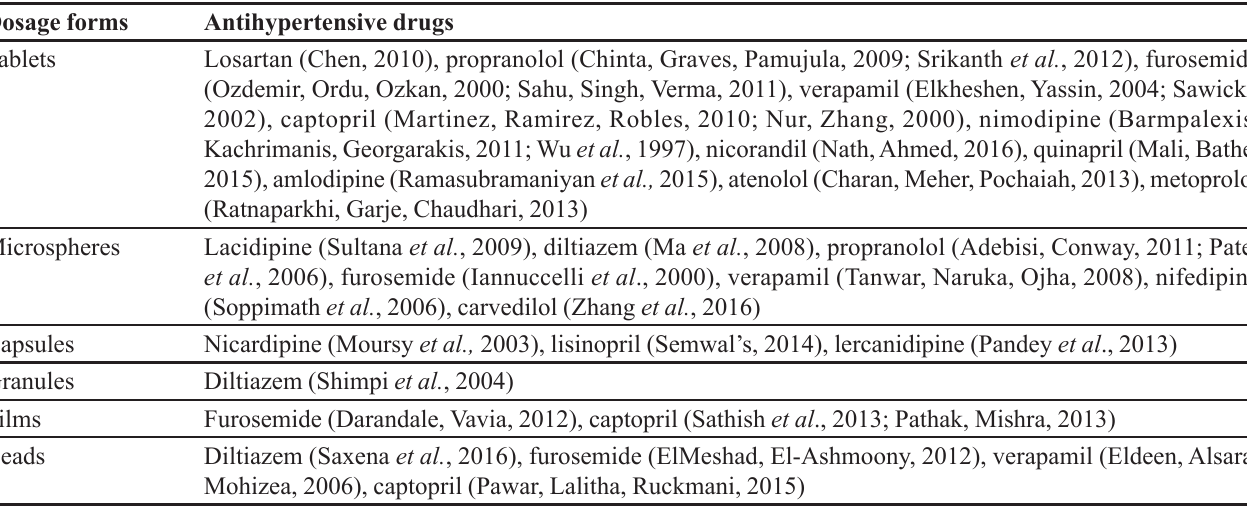
TABLE II - Summarized compilation of antihypertensive drugs explored for various GRDDS Dosage forms Antihypertensive drugs